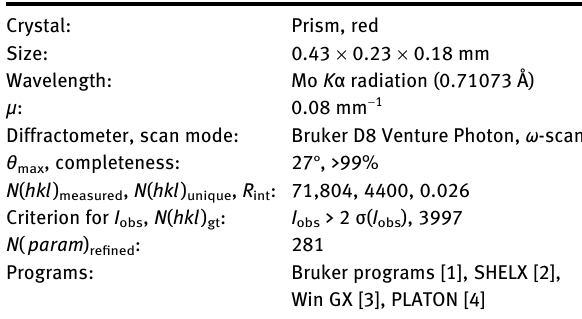
Table  : Data collection and